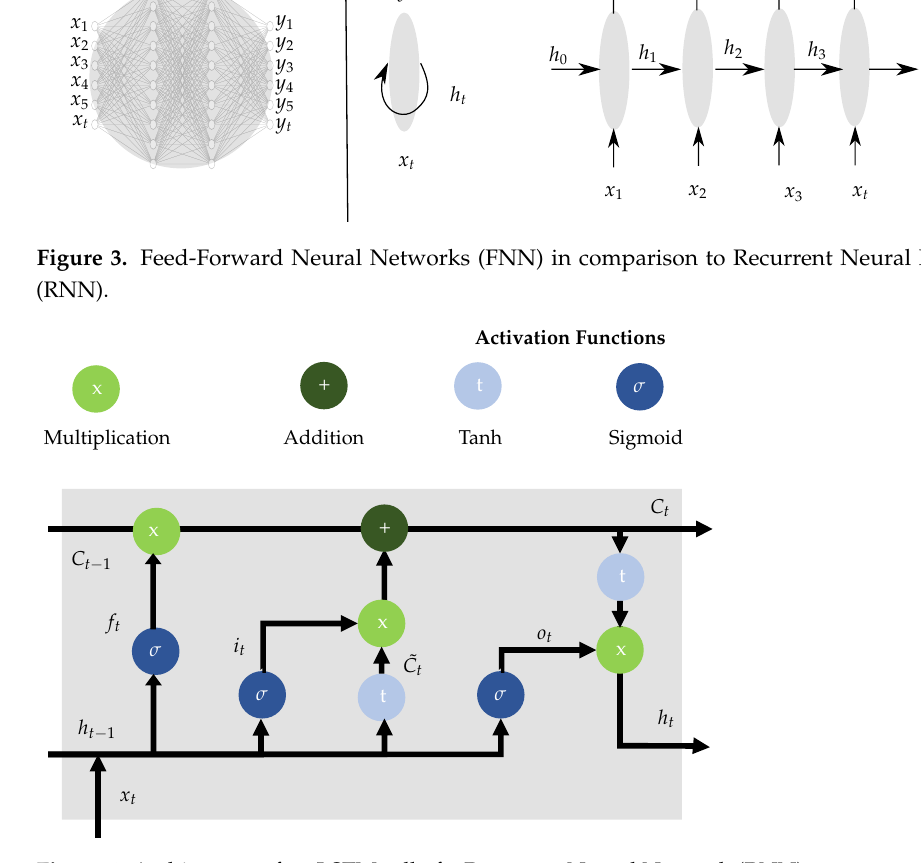
Figure 3. Feed-Forward Neural Networks (FNN) in comparison to Recurrent Neural Networks (RNN)